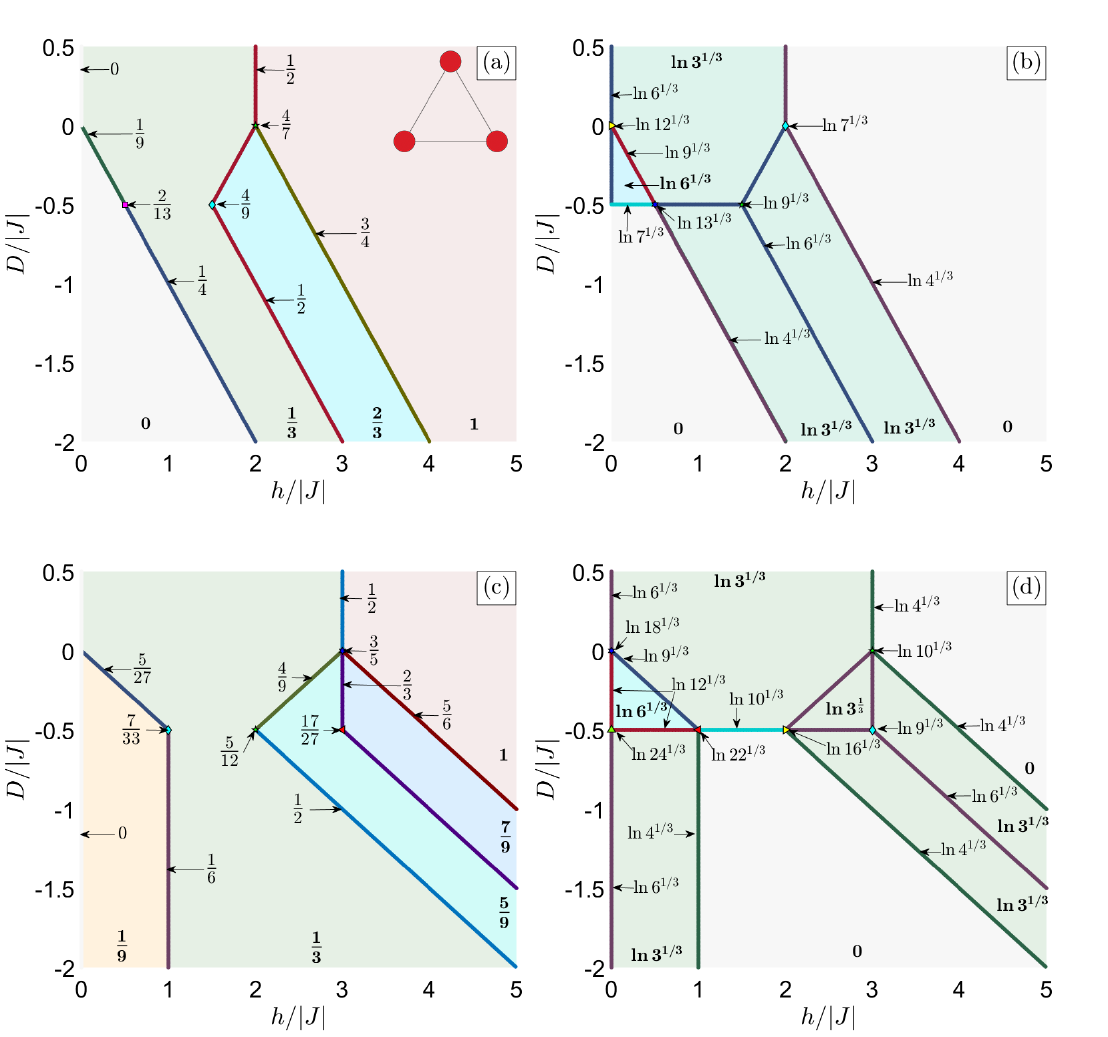
Figure 1. Ground state values of ( a , c ) the normalized magnetization m / m sat and ( b , d ) the entropy density S / Nk B of the T cluster with ( a , b ) s = 1 and (c,d) s = 3/2, in the ( h / | J | , D / | J | ) parameter plane. Boldface (plane) values correspond to the interior (boundaries) of the respective phases. The inset in panel ( a ) shows the T